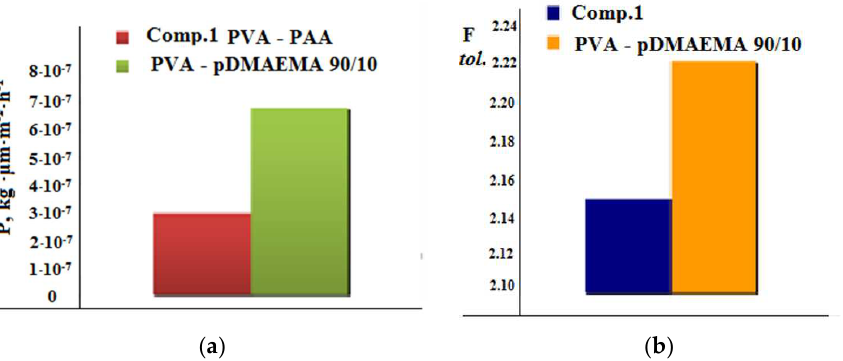
Figure 11. Comparison of the transport characteristics of the membranes based on the 80/20 PVA-PAA blend (composition 1) and the 90/10 PVA-pDMAEMA blend in the separation of the toluene/n- heptane mixture: ( a ) P is the permeability in kg (cid:215) µm (cid:215) m −2 (cid:215) h −1 ; ( b ) F is the separation factor.